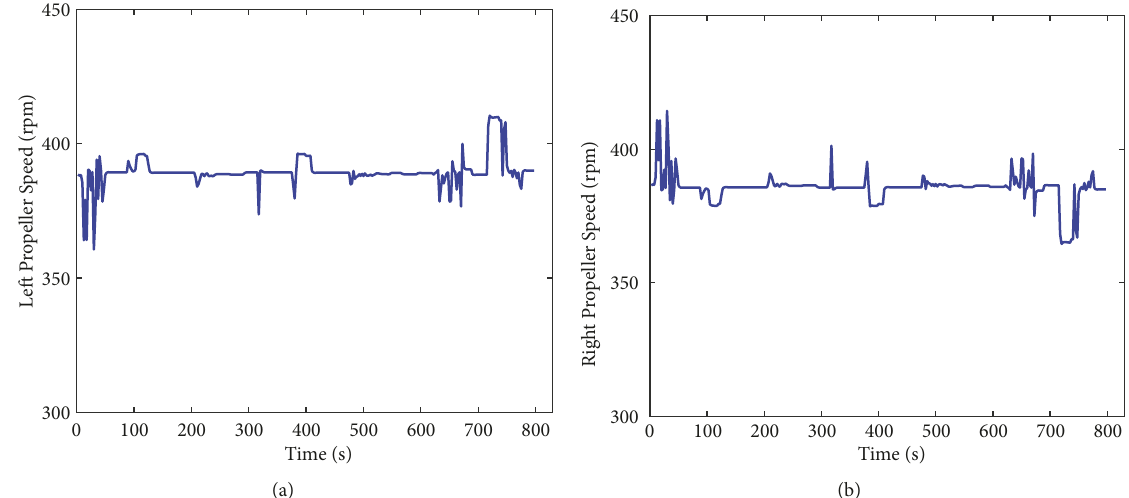
Figure 18: Curves of propeller speed controlling feedback corresponding with LSTM45.